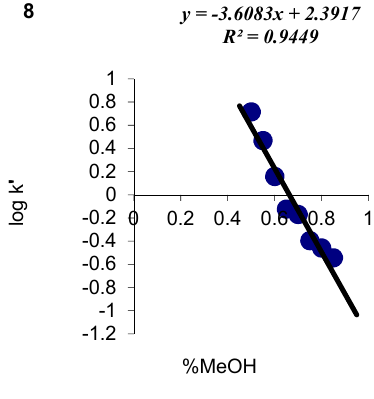
Figure 3. An experimental correlation between log k’ and the volume fraction of methanol mobile phase for compound 8